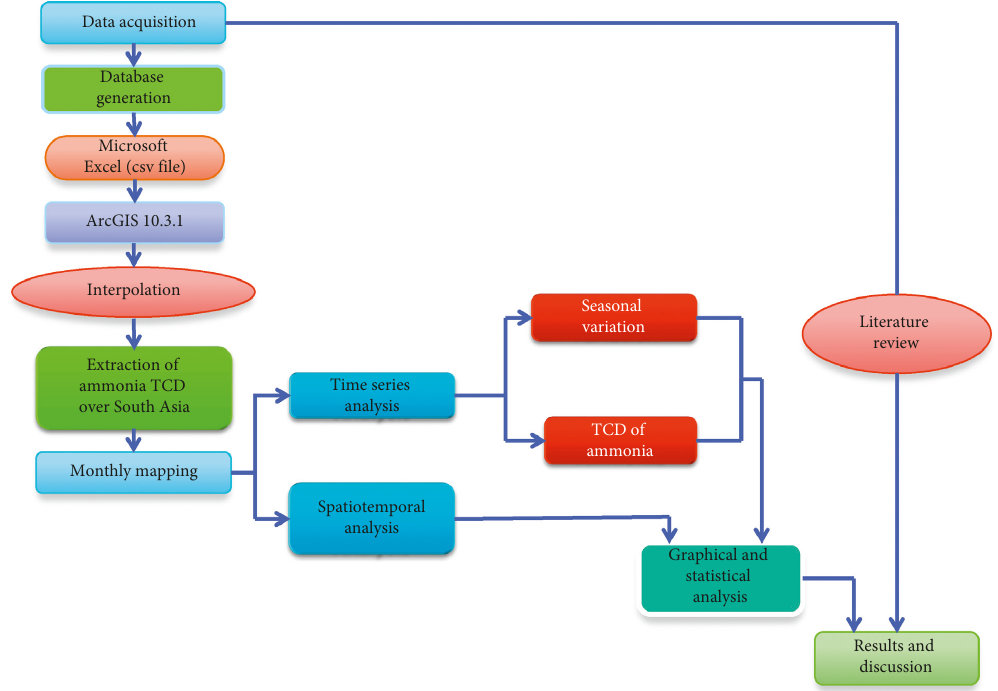
Figure 1: Methodology flow chart exhibiting the datasets, procedure, and tools used in this